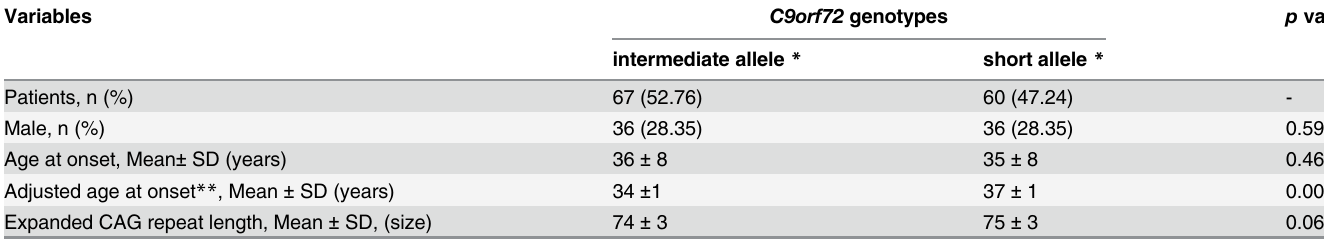
Table 2. Descriptive statistics of the age at onset analysis of SCA3/MJD